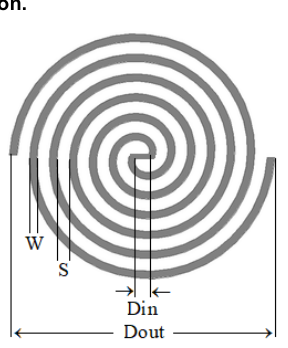
Figure 3. The geometrical form of the proposed spiral electrode for TENG. 4.